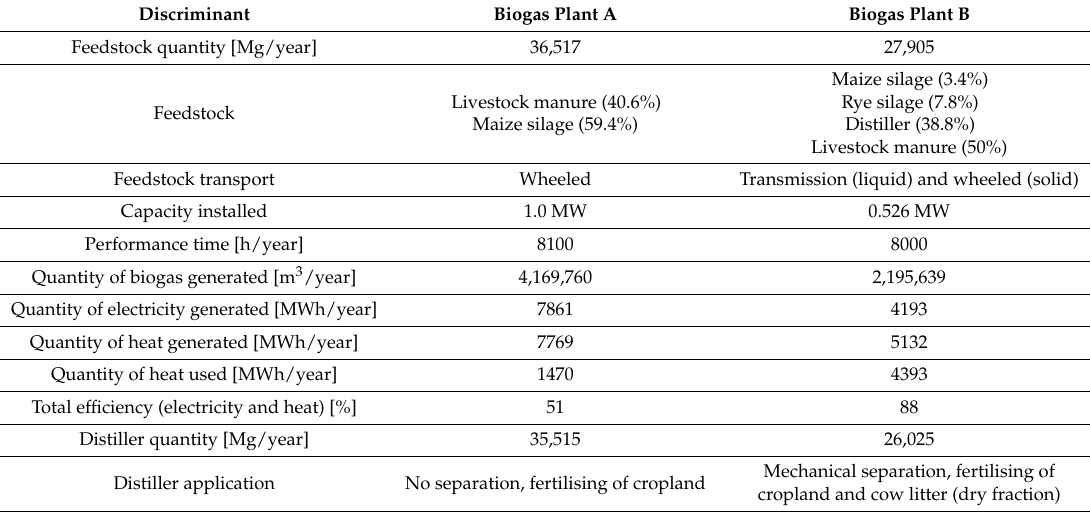
Table 1. The most important parameters of the tested agricultural biogas